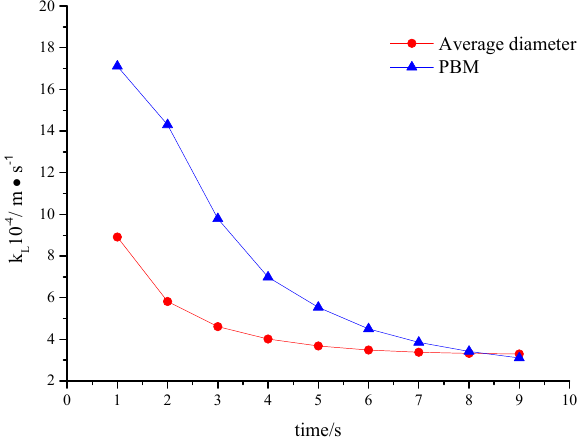
Figure 12. Variation of k L in different schemes.